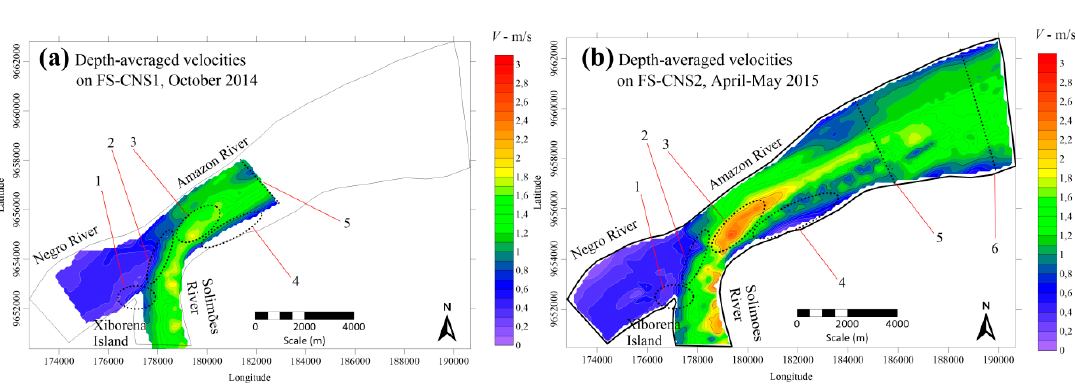
Figure 4. Map of the depth-averaged velocities about Negro/Solimões confluence on (a) FS − CNS1 and (b) FS − CNS2, with the location of the hydrodynamics features. Legend: (1) stagnation zone; (2) region of deflection; (3) region of maximum velocity; (4) downstream separation zone; (5) beginning of the region of flow recovery; and (6) end of the confluence hydrodynamic zone.